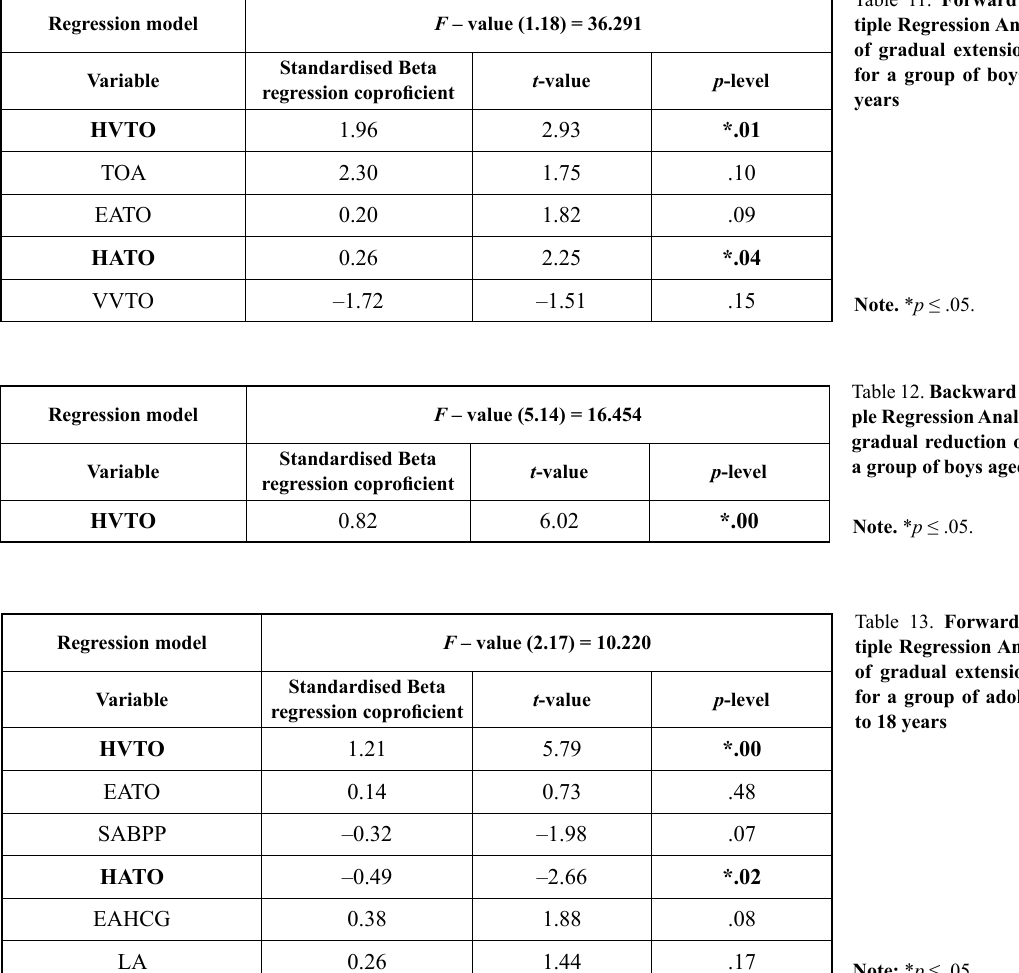
Table 11. Forward Stepwise Mul -